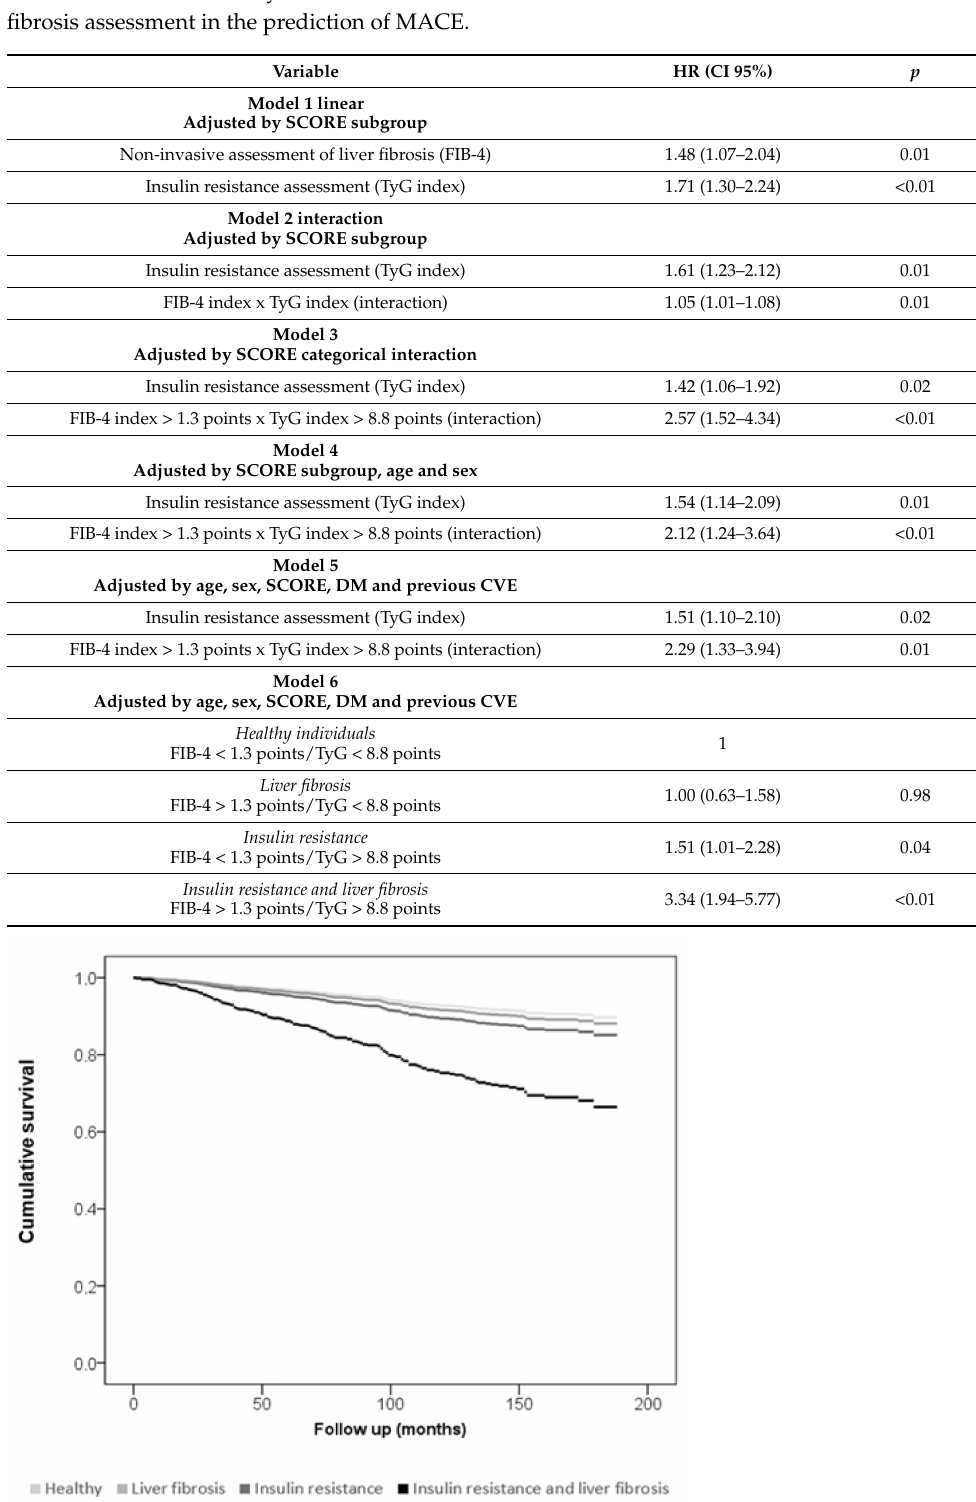
Figure 2. Kaplan–Meier graph for Cox regression analysis of the combination of insulin resistance and liver fibrosis in the prediction of MACE adjusted by cardiovascular risk (Log rank <